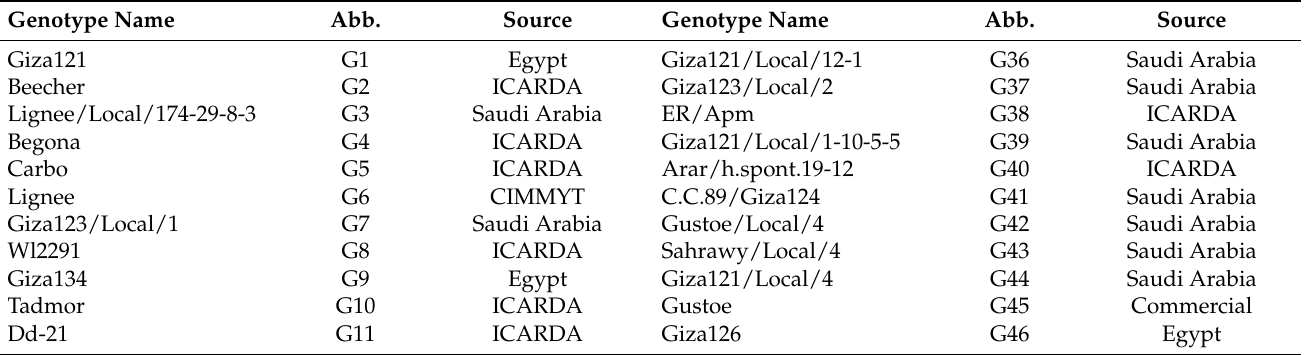
Table 1. Full name, abbreviation (Abb.), and source of the different barley genotypes used in this study. Genotype